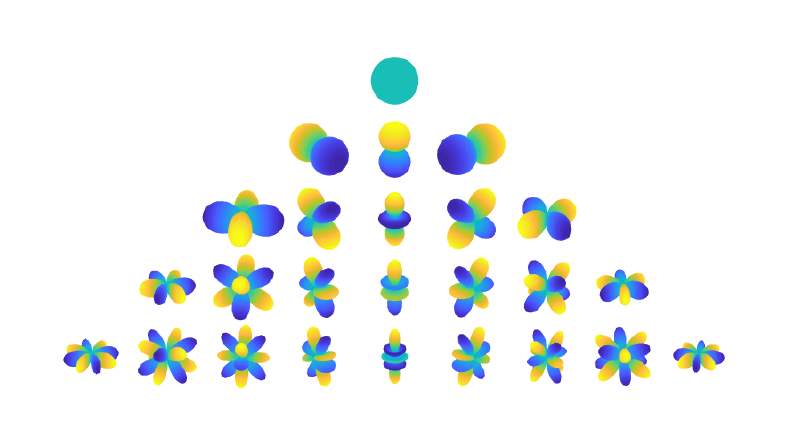
Figure 7. Spherical harmonic bases up to L =